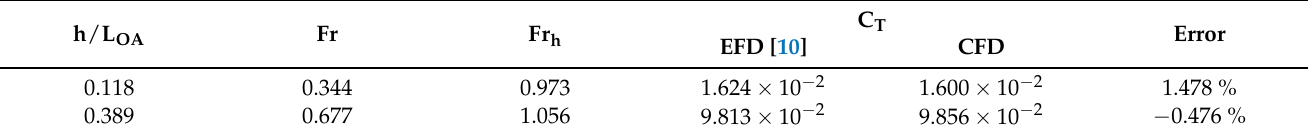
Table 6. Comparison of calm-water resistance tests for Delft 372